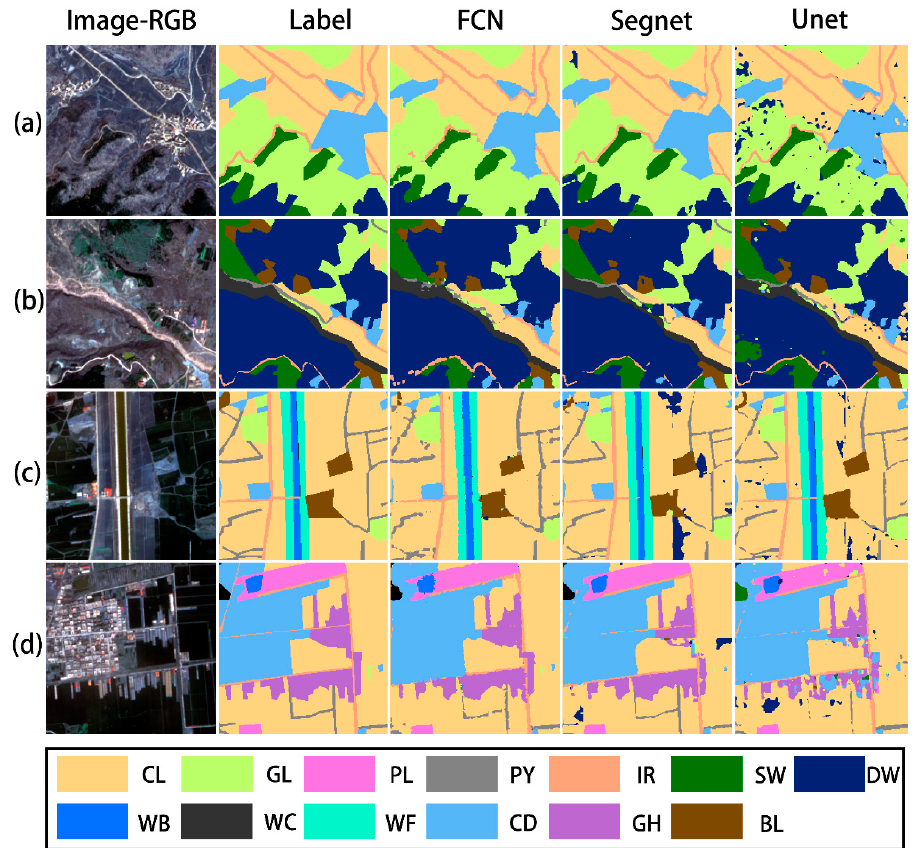
Figure 3. Four typical image subsets ( a – d ) in the study area with different classification results using only three bands (R + G + B). Columns from the left to right represent the original images (R + G + B bands), label map, FCN-8s classification, Segnet classification, and Unet classification, respectively. CL represents cereal land, GL represents grassland, PL represents poplar land, PY represents pathway in farmland, IR represents the impervious road, SW represents sparse woods, DW represents dense woods, WB represents water bodies, WC represents a waterless channel, WF represents water conservancy facilities, CD represents construction land, GH represents greenhouse, and BL represents bare land.